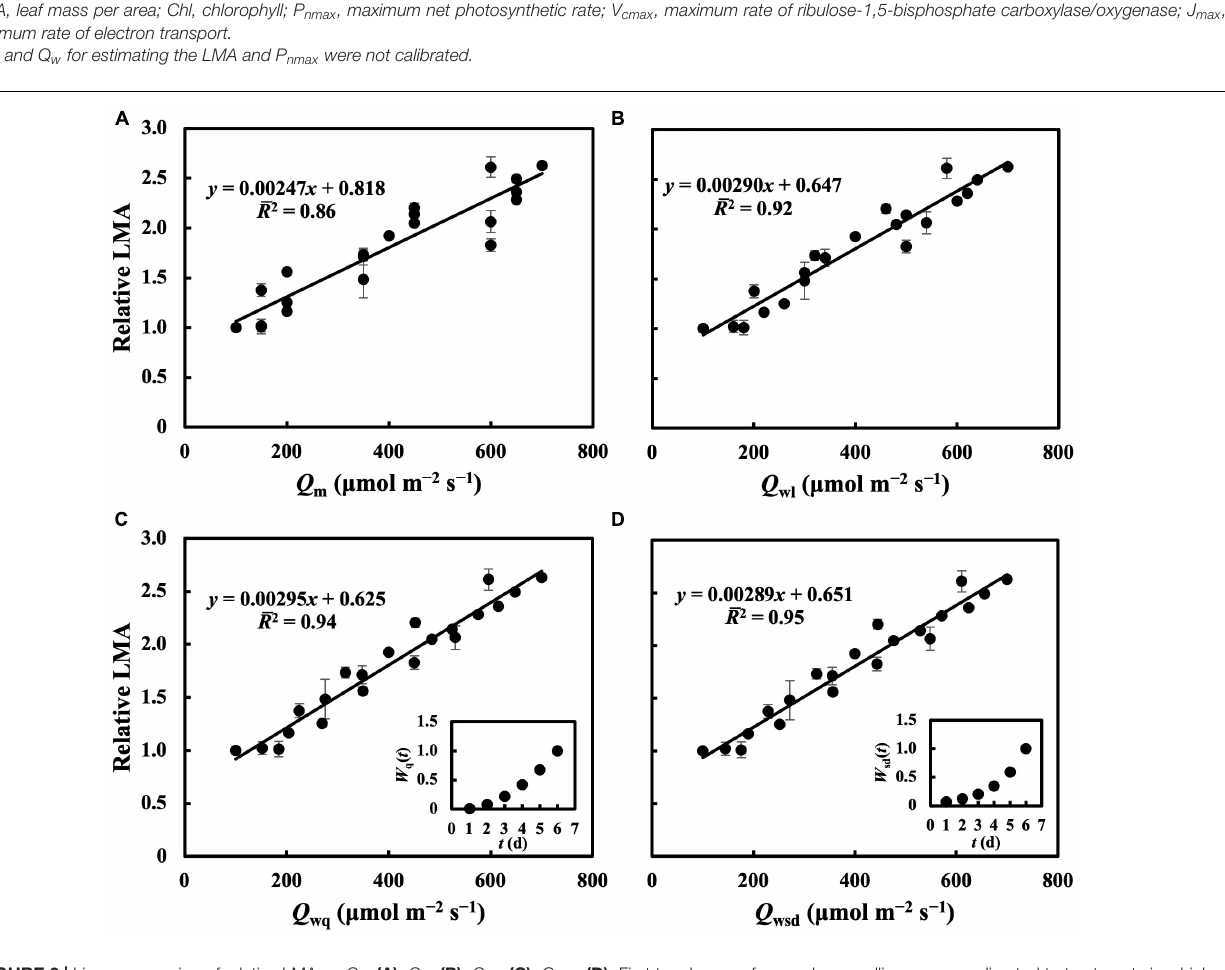
Frontiers in Plant Science |